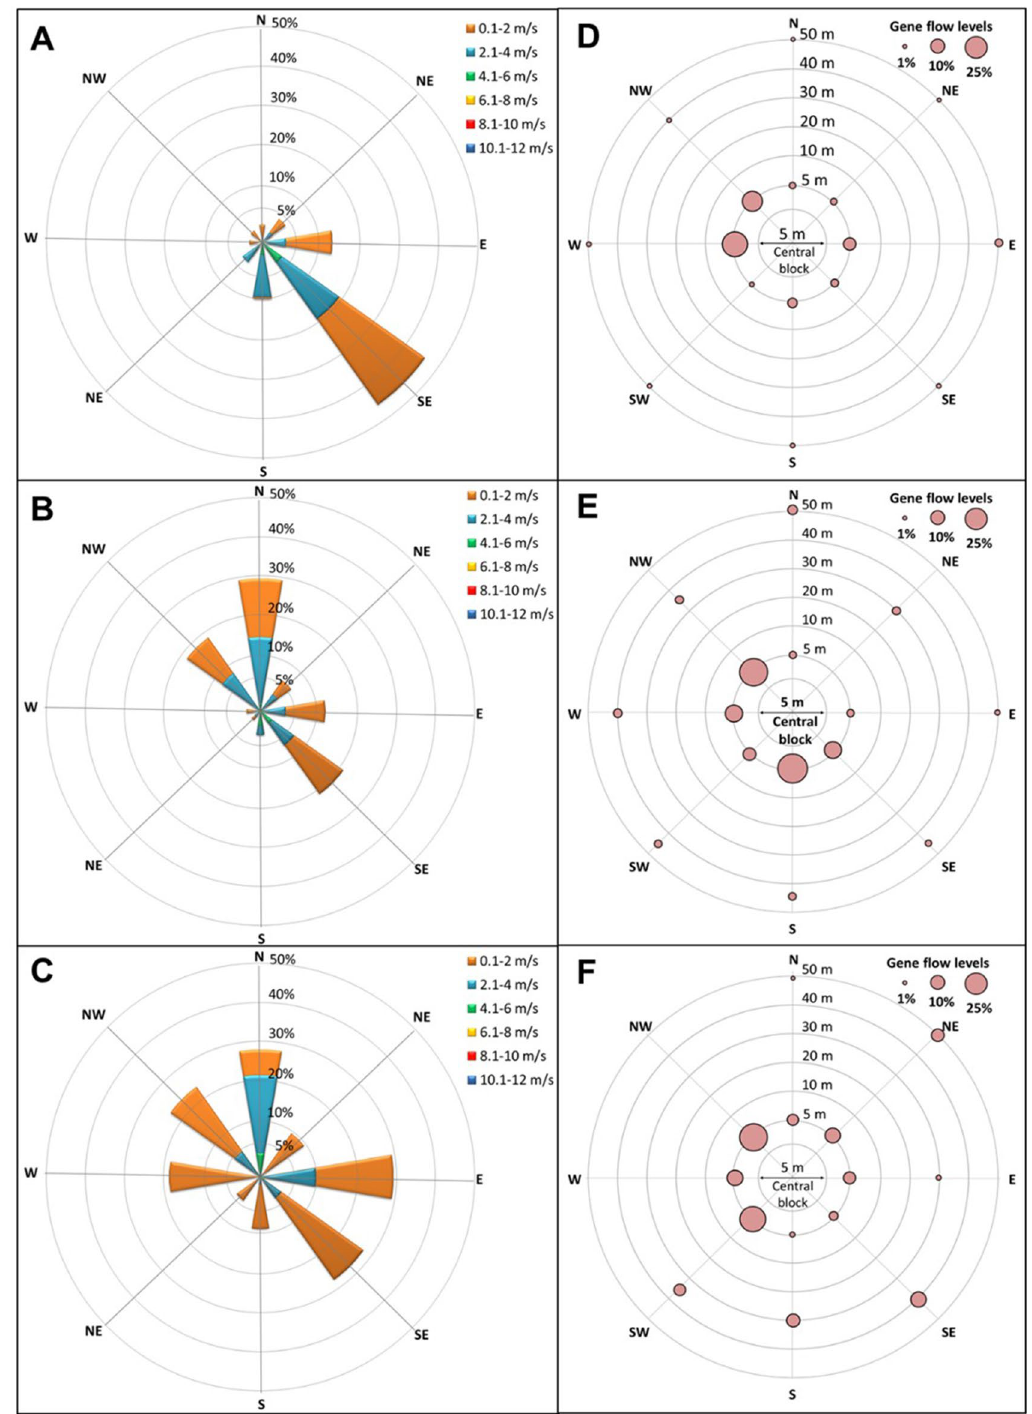
Figure 4. ( A – C ) Windrose plots illustrating the speed (m/s) and frequency (%) of wind events in the four cardinal (N, E, S, W) and four ordinal (NE, SE, SW, NW) directions at the experimental site during johnsongrass flowering in ( A ) Environment 1, Jun–July, 2018; ( B ) Environment 2, October–November, 2018; and ( C ) Environment 3, August–September, 2019. Wind speed was grouped into various categories, depending on the overall wind speed recorded during the observation period. ( D – F ) Gene flow (%) at the closest (5 m) and the farthest (50 m) distance of detection in all eight directions for the environments corresponding with ( A ) to ( C ). The size of the circles provides a reference for gene flow